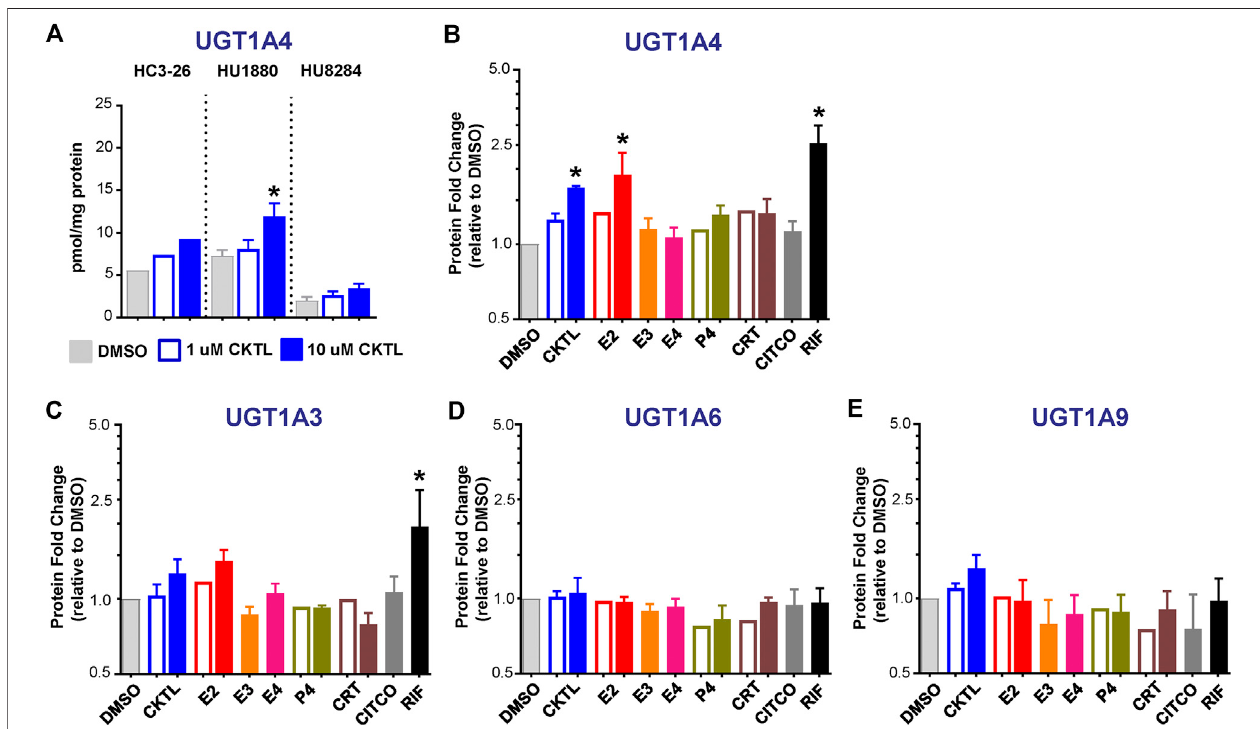
FIGURE 6 | Effect of pregnancy-related hormones (PRH) on protein concentrations of UGT1A4 and other key UGT1A isoforms in SCHH. Following 72 h of PRH exposure, UGT1A4 protein concentrations were quanti fi ed by quantitative targeted absolute proteomics in SCHH membrane-associated protein fractions isolated from threedonors(HC3-26,HU1880,andHU8284). (A) UGT1A4absoluteproteinconcentrationsintheDMSOandPRHcocktail(CKTL)groupswerecomparedseparatelyin donor HC3-26 (mean: n (cid:2) 2 per group) and donors HU1880 and HU8284 (mean ± SEM: n (cid:2) 3 – 4 per group; * p < 0.05 vs. DMSO, ^ p < 0.05 1 vs. 10 µM). Comparisons of PRH CKTL effects on UGT1A3, UGT1A6, and UGT1A9 concentrations within each hepatocyte donor are provided in Supplementary Figure S3 . (B) UGT1A4, (C) UGT1A3, (D) UGT1A6,and (E) UGT1A9proteinconcentrationswereexpressedrelativetovehiclecontrol(DMSO)withineachhepatocytedonor,andthen combined for comparison across groups. Open bars represent 1 µM CKTL (mean ± SEM: n (cid:2) 3 donors per group) and 1 µM for the individual hormones (mean: n (cid:2) 2 donors per group). Solid bars represent 10 µM CKTL and 10 µM for theindividual hormones (mean ± SEM: n (cid:2) 3 donors per group). * p < 0.05 vs. DMSO, ^ p < 0.05 1vs. 10 µM. Comparison of individual PRH effects on UGT1A4 levels within each hepatocyte donor is provided in Supplementary Figure S2C .